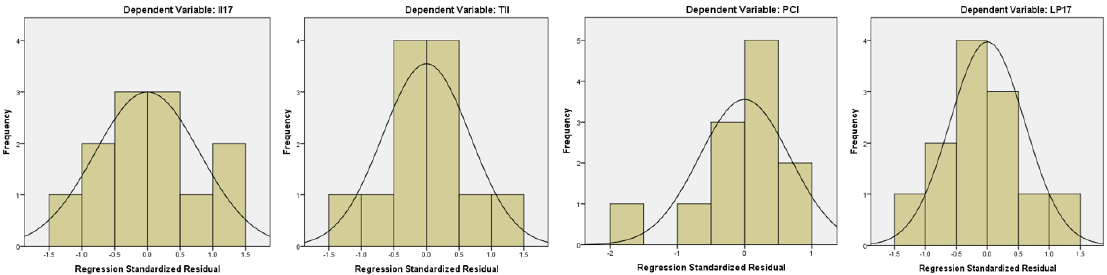
Figure 10. Histogram. Figure 10.